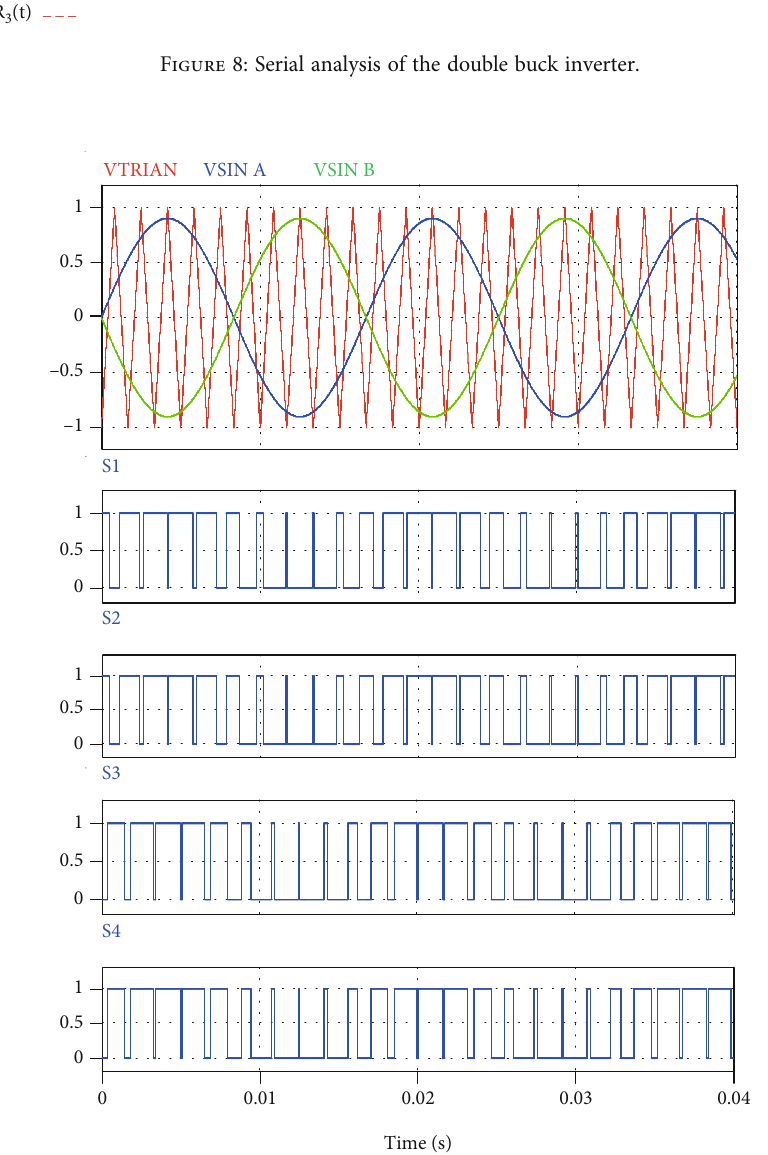
Figure 9: Unipolar modulation and control signals. (a – e) Modulation signals (0.5 V/div) and control signals (1